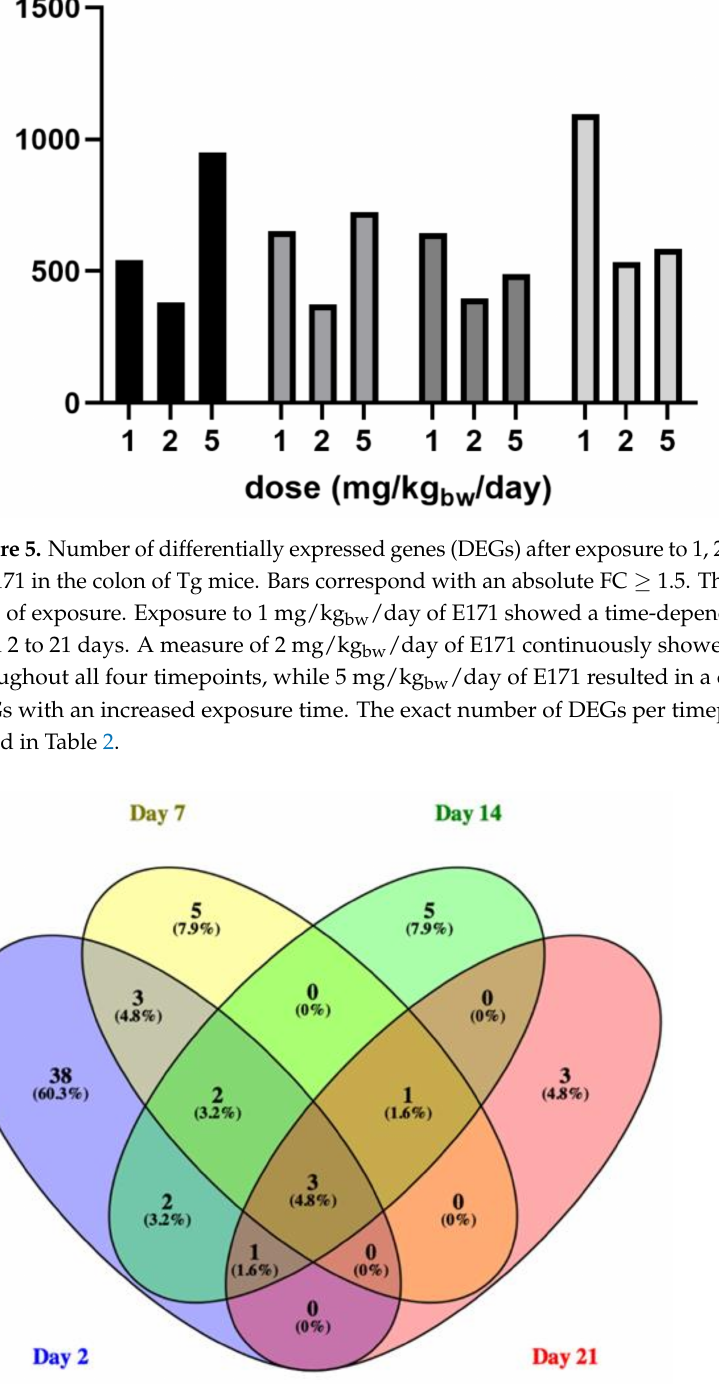
Figure 6. The Venn diagram shows the number of 5% FDR-corrected DEGs (absolute FC ≥ 1.5 and q-value < 0.05) and their overlap after the exposure to 1 mg/kg bw /day of E171 at 2, 7, 14, and 21 days. The three genes, Dbp, Nr1d1, and Nr1d2, were continuously modulated at all timepoints. After 2, 7, and 14 days of exposure, Arntl/Bmal1 and Nfil3 were modulated. Rorc was modulated at days 7, 14, and 21, while Nfkbiz was modulated after 2, 14, and 21 days of exposure to 1 mg/kg bw /day of